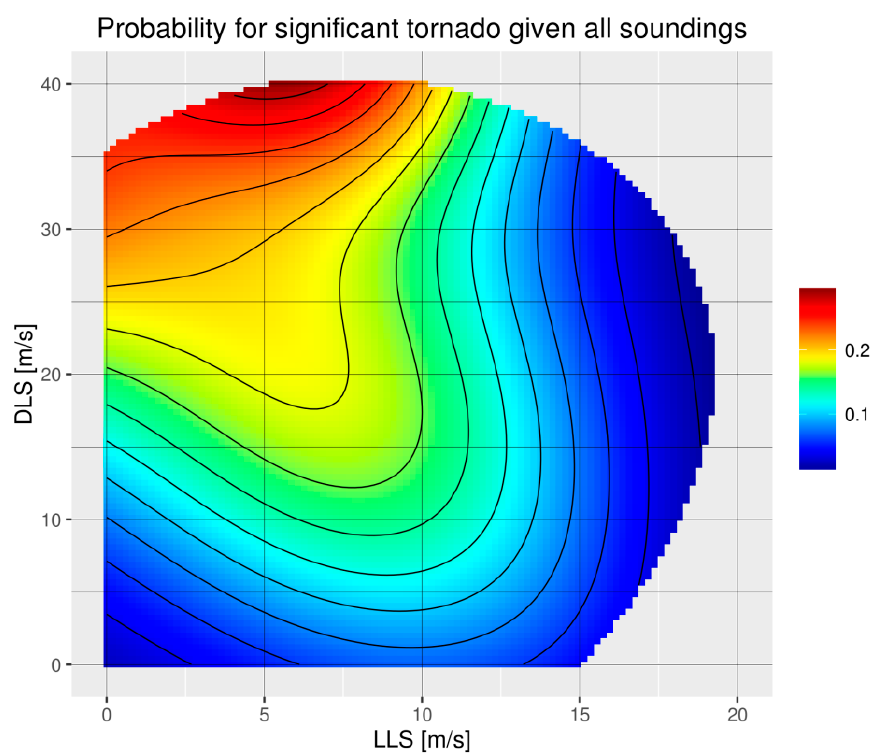
Figure 15. As in Figure 9, except for significant (F1+) tornadoes.